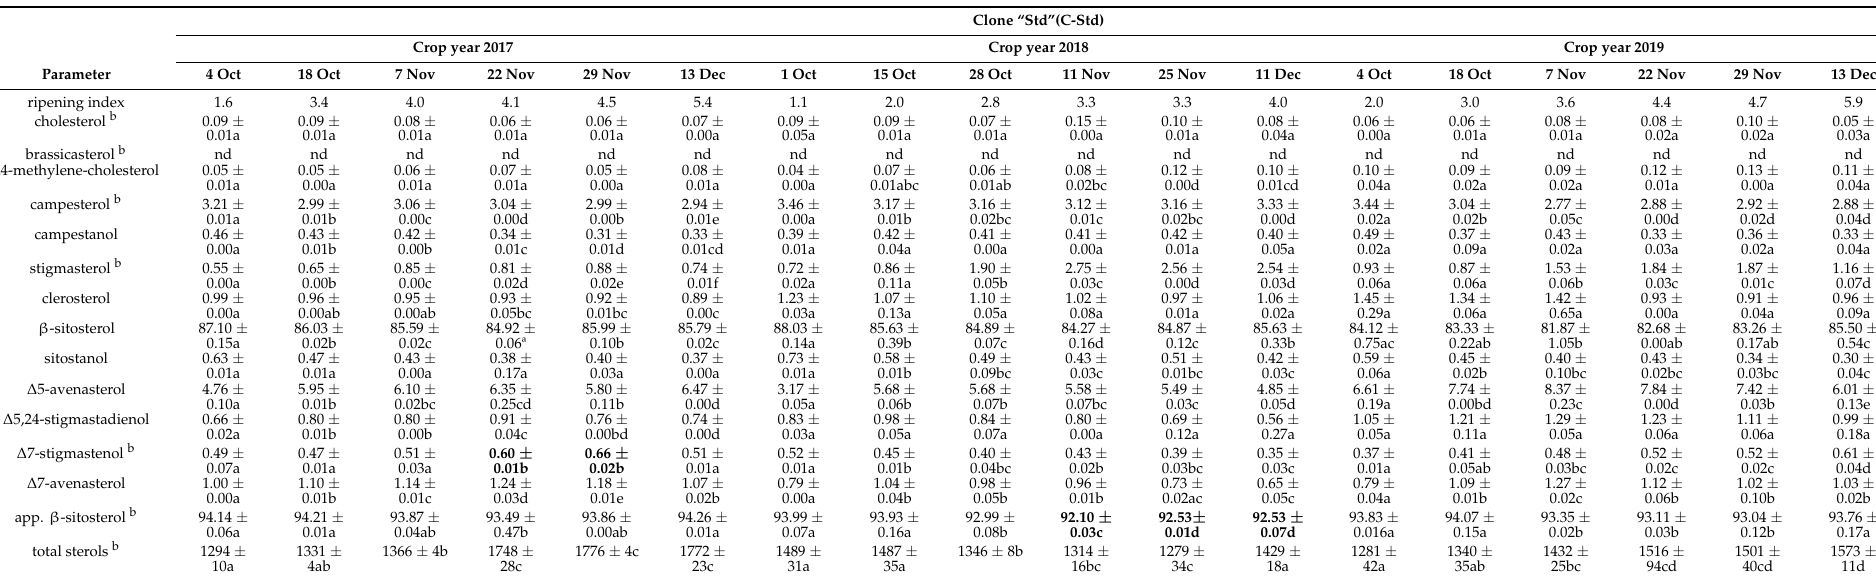
Values are mean ± standard deviation ( n =2). a Different letters for each parameter indicate significant statistical differences ( p < 0.05) among picking dates for each crop year (a–f). b Limits established by the current regulation: total sterols ≥ 1000 mg/kg; cholesterol ≤ 0.5%; brassicasterol ≤ 0.1%; campesterol ≤ 4.0%; stigmasterol ≤ campesterol; ∆ 7-stigmastenol ≤ 0.5%; app. β -sitosterol ≥ 93.0%. Values in bold: non-compliance. Not detected =